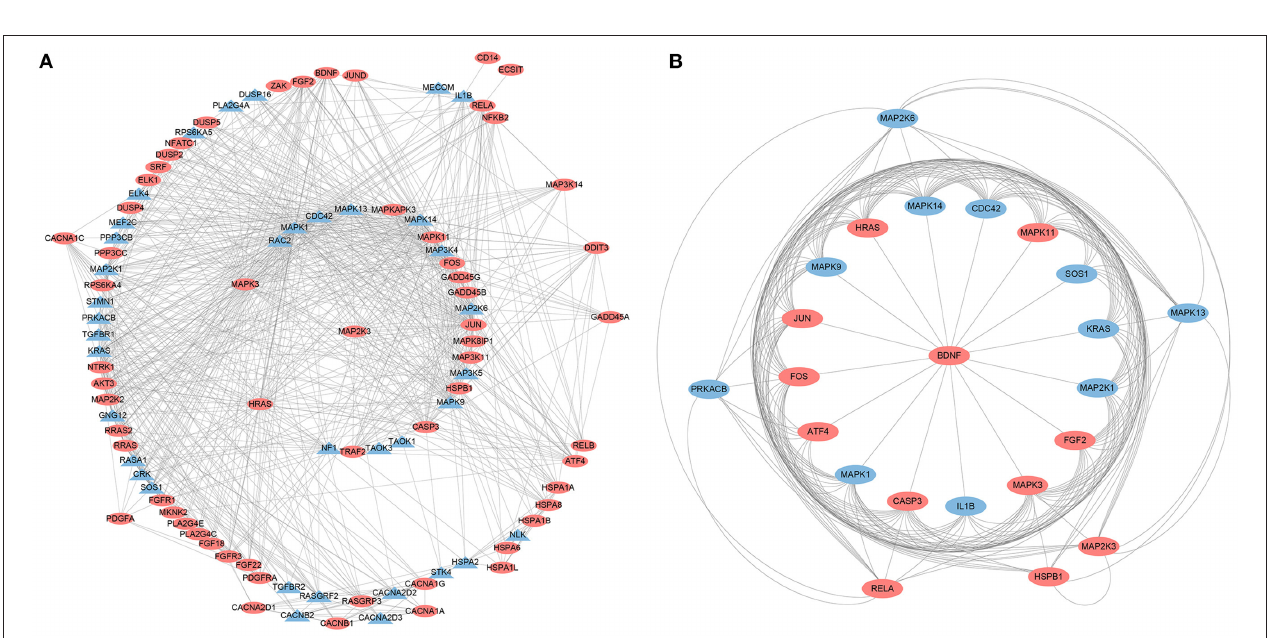
FIGURE 7 | The PPI analysis of DEGs in the MAPK signaling pathways. (A) The entire PPI network of annotated interactions between genes. (B) A sub-network module for the hub genes. Red circles represent up-regulated genes, blue circles represent down-regulated genes.